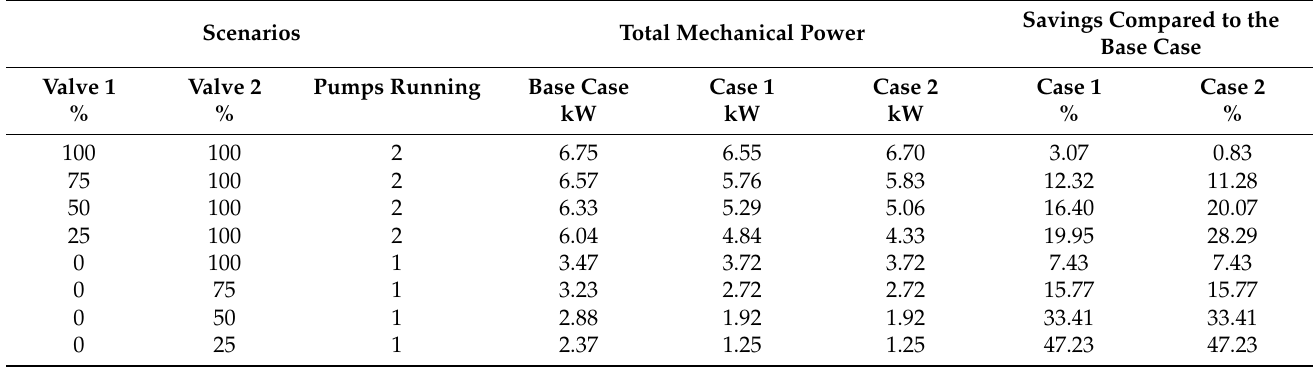
Table 2. Power consumption and savings for various operating scenarios.